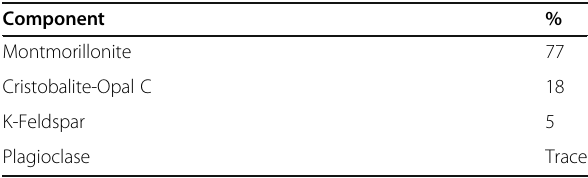
Table 2 Mineralogical analysis of